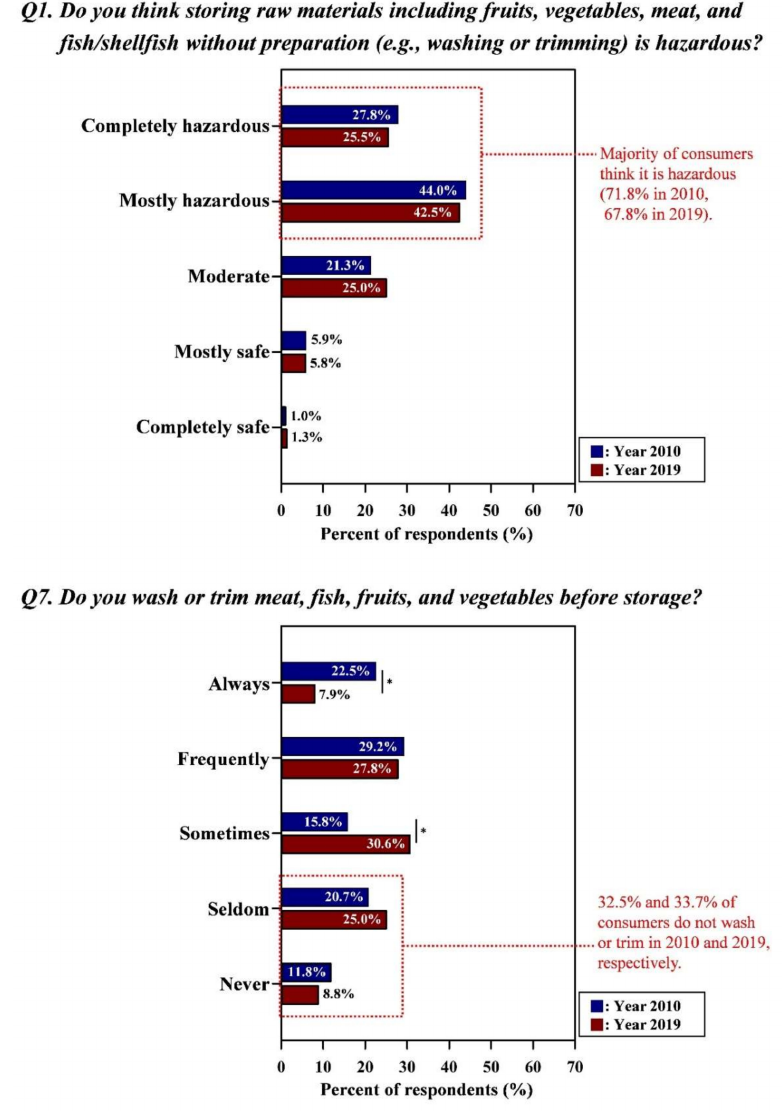
Figure 1. Gap between the consumers’ perceptions and behaviors regarding the storage of perishable foods without washing and trimming. Asterisk (*) indicated between graphs means the significant di ff erences of responses (the Kruskal-Wallis test; p < 0.05) in each answer option from Year 2010 and